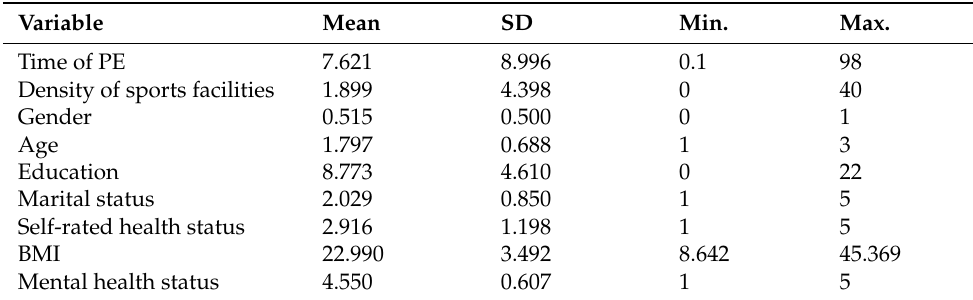
Table 1. Summary of the sample ( n =